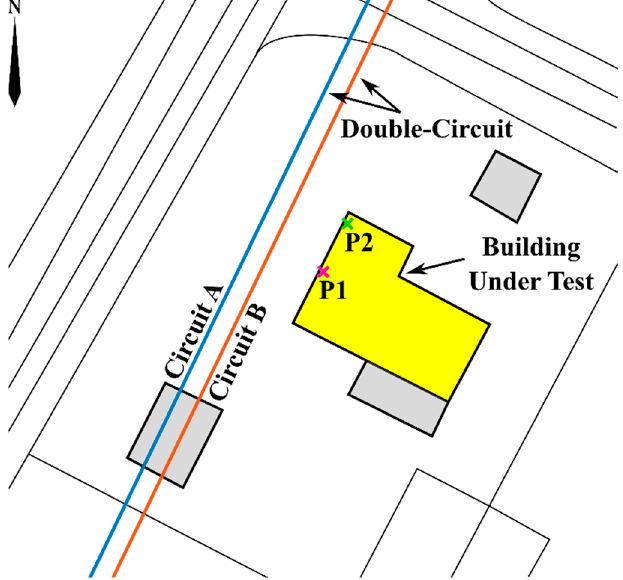
Figure 3. Cartographic representation of the building under test.